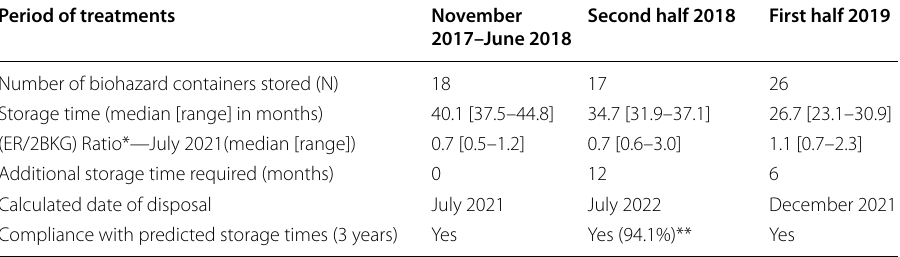
* ER Exposure rate measured in contact with the container; 2BKG background **Only 1 of 17 containers with an ER of 0.3 μSv.h − 1 requires 12 additional months for decay. Others were disposed of in July 2021 Table 5 Data for N partially used vials discarded in 2 bags, measured to determine (ER/2BKG) ratios Period of